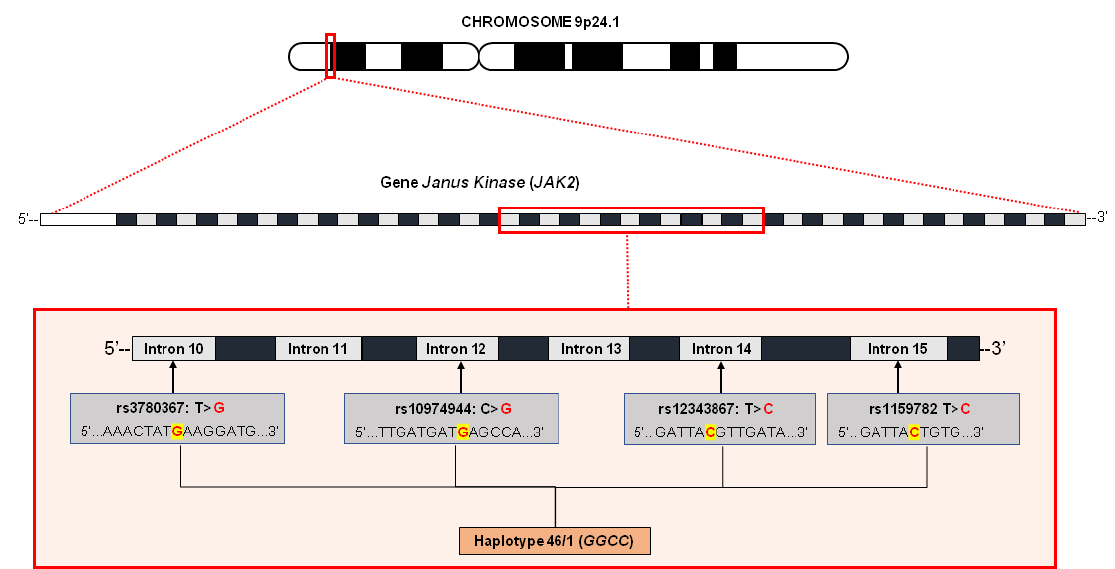
Figure 4. Characterization of the 46/1 haplotype without JAK2 gene. The haplotype, also called GGCC, is altered by four variants located in intron 10 (rs3780367: T > G), intron 12 (rs10974944: C > intron 14 (rs12343867: T > C) and intron 15 (rs1159782: T > C). It is believed that the presence of